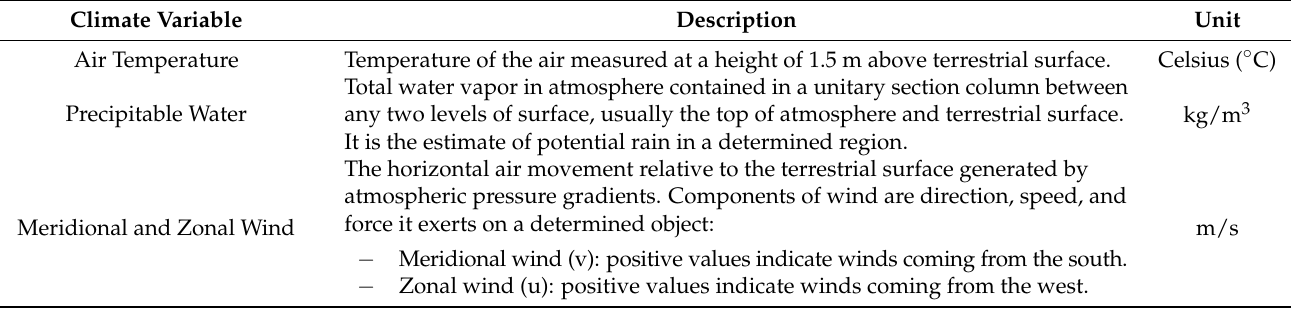
Meridional and Zonal